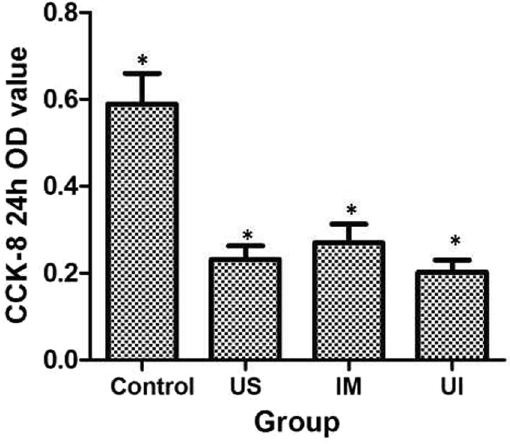
Figure 7. Absorbance at 450 nm, indicating proliferation capacity according to the CCK-8 test, was weakest in the UI group ( * P < 0.05 compared with other